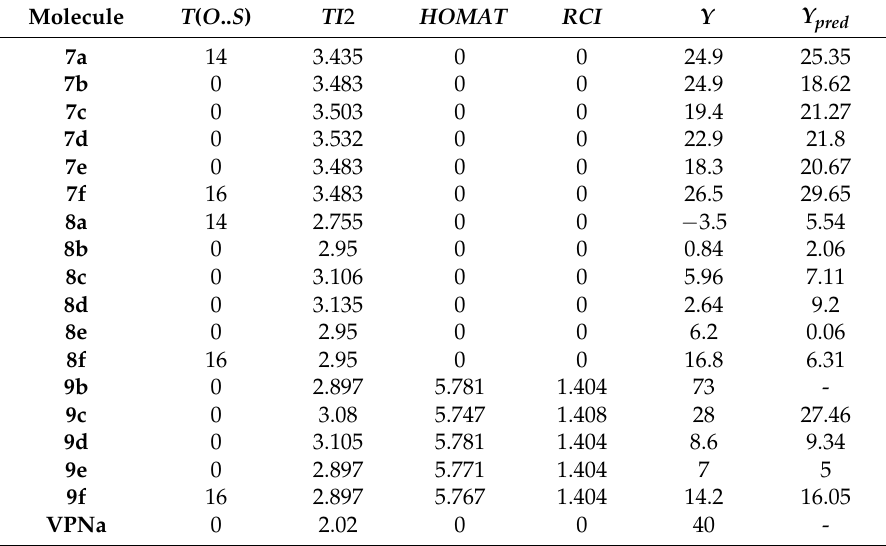
Table 6. Molecular descriptors values, experimental GABA-AT inhibition % ( Y ) and predicted ( Y pred ) of GABA derivatives present in the QSAR